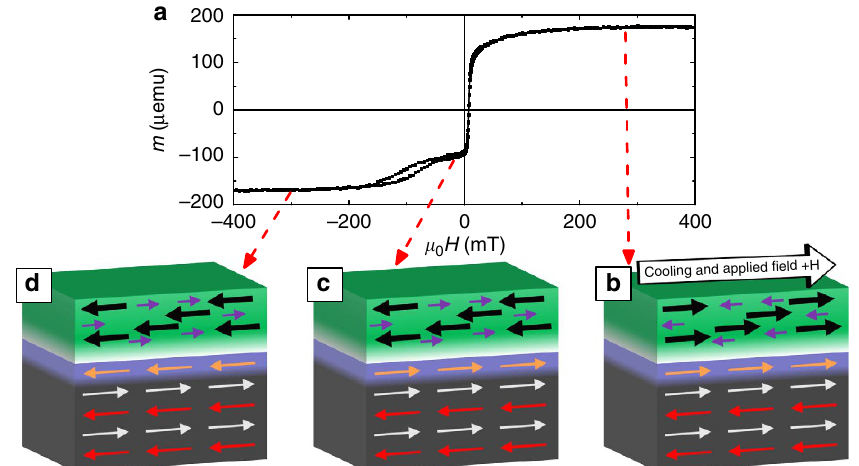
Figure 5 | Schematic illustrations of sample C magnetic configurations. Configurations during ( a ) the magnetic hysteresis loop measurement at room temperature are given at ( b ) saturation, ( c ) GdFe reversal and ( d ) NiCo reversal. In the layer structure, from top to bottom, the layers are GdFe (green), GdO y and GdFe mixture (white), NiCo (blue) and NiCoO (black), respectively. Arrows in the layers indicate the